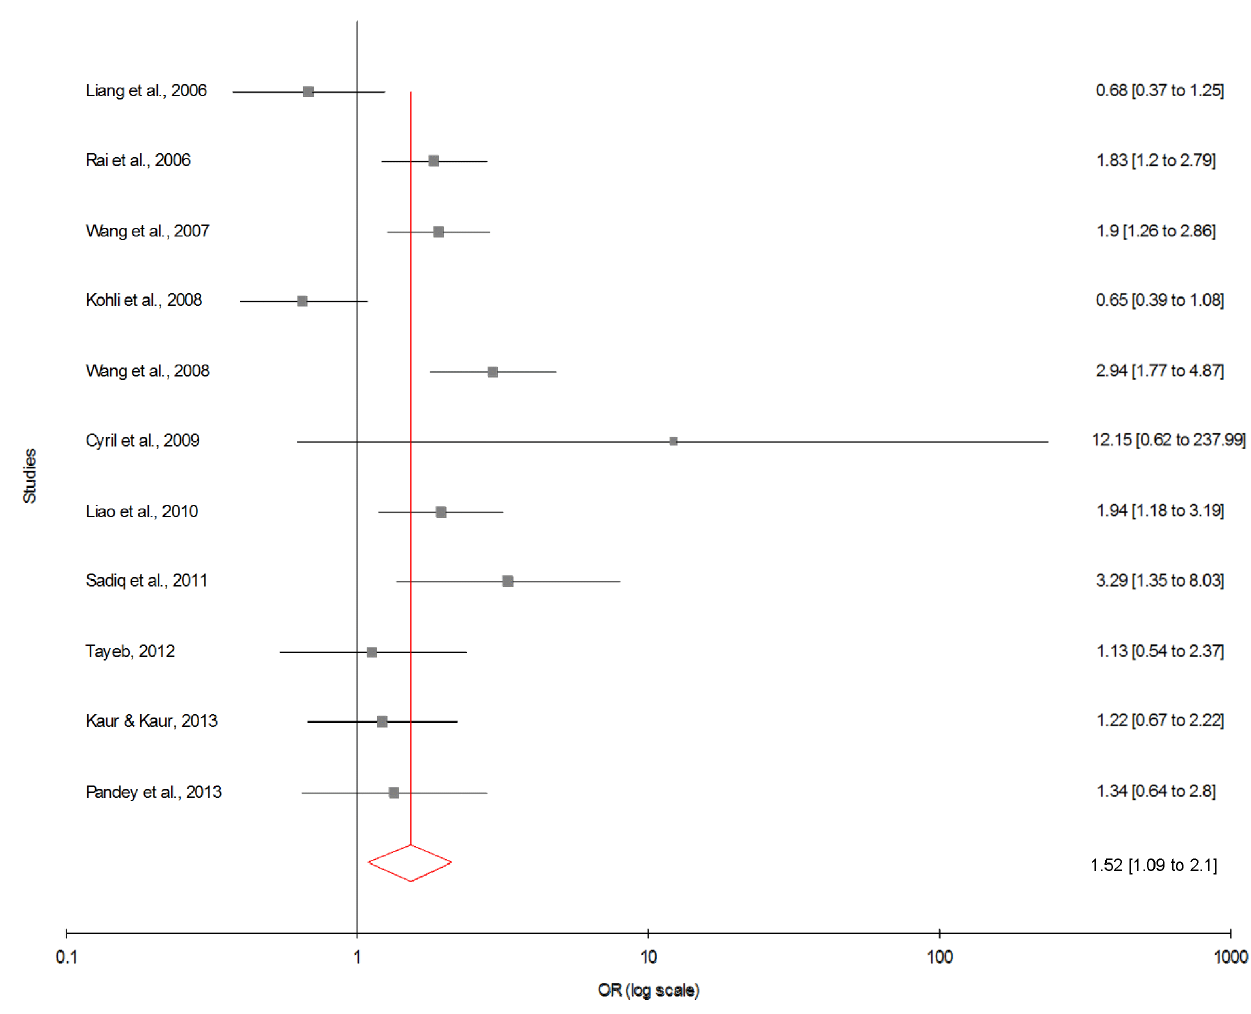
Figure 5. Forest plots (Random effect) showed significant association between MTHFR C677T polymorphism and risk of Down syndrome in Asian studies using allele contrast model (T versus C). Results of individual and summary OR estimates and 95% CI of each study were shown.